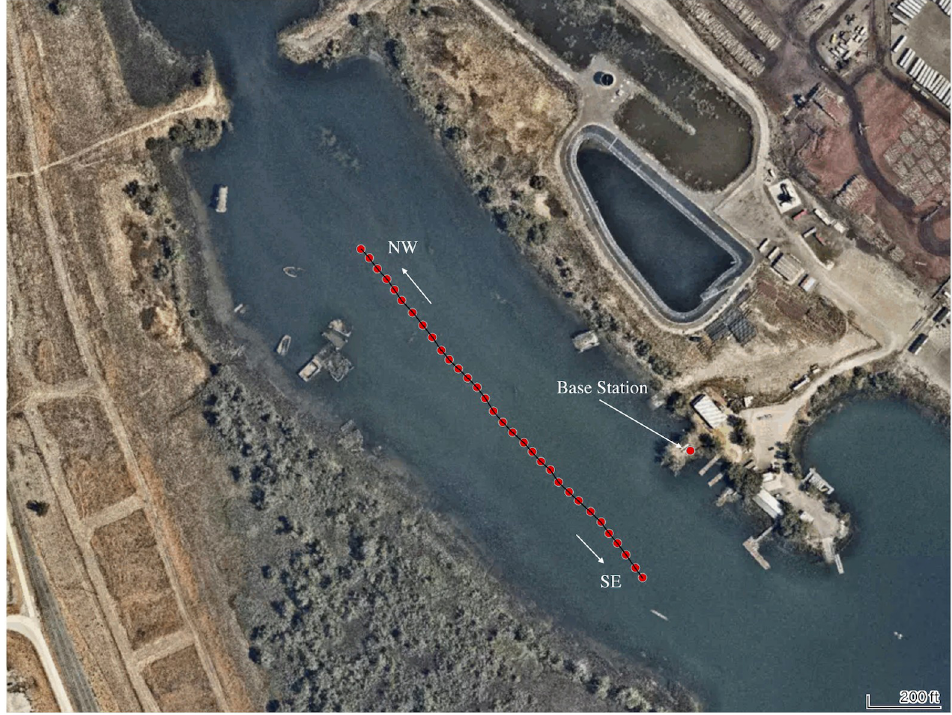
Fig 7. Satellite image showing a typical trial path. The single red dot on the shore is the location of the DGPS base station. The mean latitude and longitude are 38.566435˚and -121.556365˚, respectively.